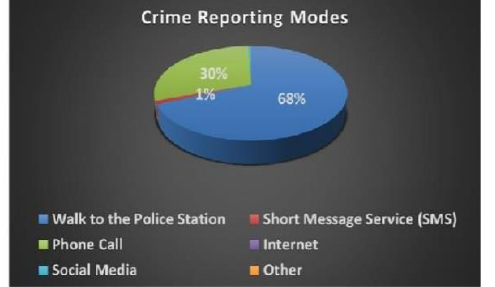
Figure 3: crime reporting modes by citizen (MWiya, et.al. 2015)